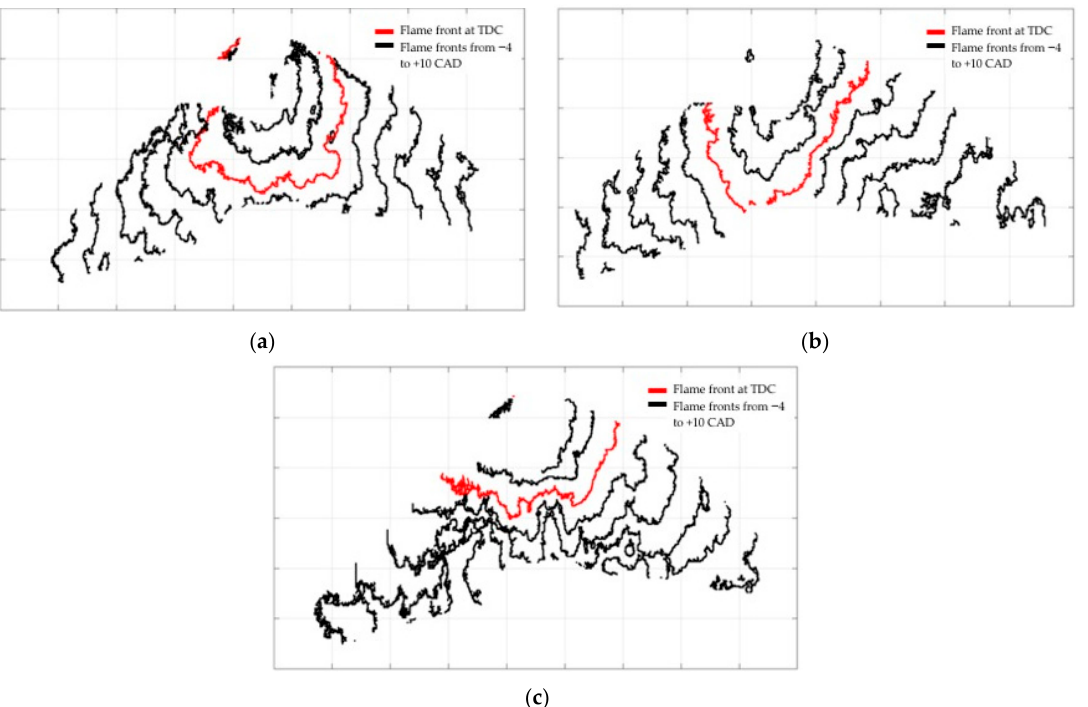
Figure 17. Flame front propagation in three consecutive engine cycles at 1000 RPM, wide open throttle: ( a ) cycle 58; ( b ) cycle 59; ( c ) cycle 60.